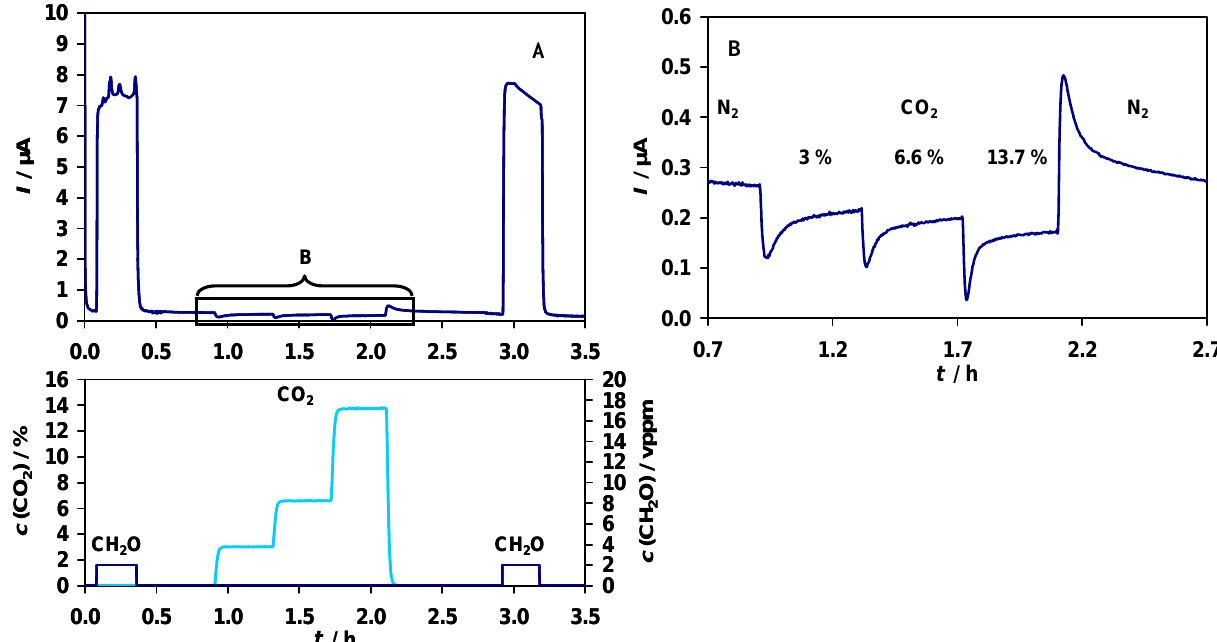
Figure 7. A) Top: Sensor signal for 2 vppm formaldehyde and interferences from CO 13.7 %). Bottom: Test cycle concentrations of CO (magnified range). axis). B) Signal to CO 2